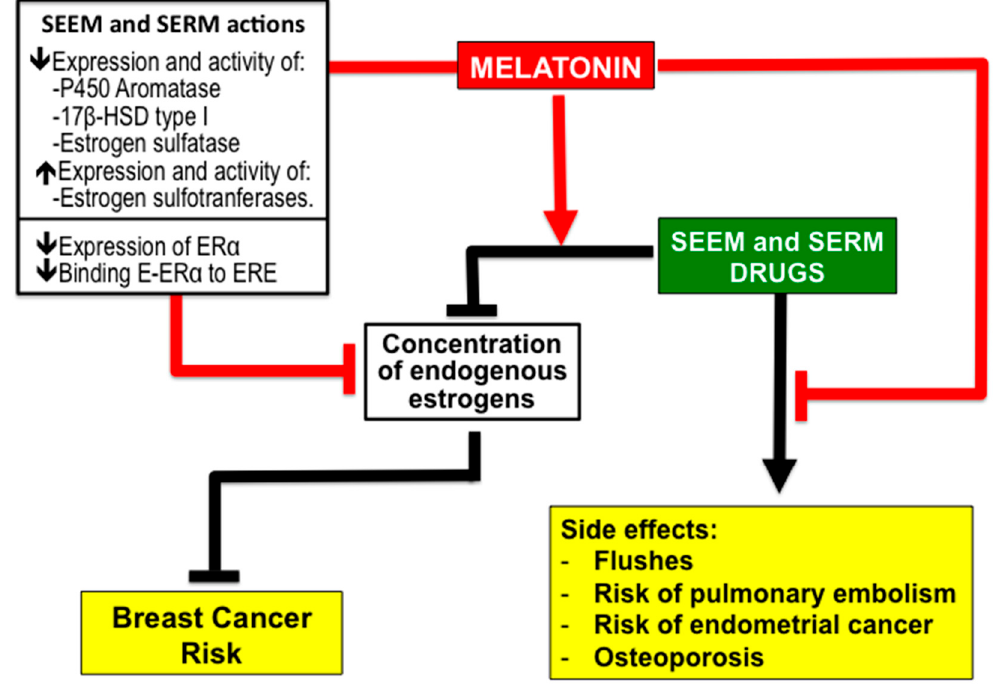
Figure 2. Summary of the evidence supporting the role of melatonin as a possible adjuvant therapy with other selective estrogen enzyme modulators (SEEM) and selective estrogen receptor modulators (SERM) drugs to reduce the risk of breast cancer. Melatonin not only has both SEEM and SERM properties, it also enhances the effectiveness of other antiestrogenic drugs while reducing or preventing their unwanted side effects. Abbreviations: 17 β -HSD, 17 β -hydroxysteroid dehydrogenase; ER α , estrogen receptor alpha; E, estradiol; ERE, estrogen response element.